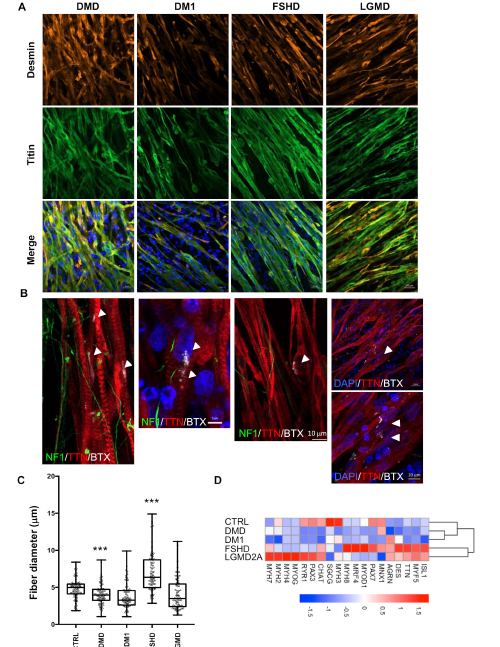
Figure 5. Structural and functional phenotyping of hiPSC-derived muscle cells from patients a ff ected by muscular dystrophy. ( A ) Representative Z stacks of myofibers at day 45 with staining of sarcomeric Desmin (DES, orange) and Titin filament (TTN, green) for Duchenne Muscular Dystrophy (DMD), myotonic dystrophy (DM1), Facio Scapulo Humeral Dystrophy (FSHD) and Limb Girdle Muscular Dystrophy Type 2A (LGMD2A). ( B ) Representative Z stacks of cultures stained for acetylcholine receptors (AChR) using Alpha Bungarotoxin coupled with Alexa 555 (White, arrows) at the surface of hiPSC-derived muscle fiber stained in red using anti-Titin (TTN, red). Antineurofilament (NF, green) was used to visualize motor neurons axons. Nuclei were counterstained with DAPI. As in the control cells, we observed the presence of several undi ff erentiated acetylcholine receptors clusters at the surface of the myofibers for the di ff erent pathologies. ( C ) We compared the muscle fiber section of the Titin-stained fibers in control cells and the four di ff erent pathologies (DMD, DM1, FSHD or LGMD2A). For each condition, 500 fibers were analyzed, and the section of the fiber was determined at three di ff erent positions along each. Box plots display the mean sizes for the di ff erent samples. Values were compared using an ANOVA multiple comparison test, followed by Brown-Forsythe and Welch correction tests; **** p < 0.0001; *** p < 0.001; ** p < 0.01. –( D ) Heatmap for expression of di ff erent muscle and motor neuron markers over time for cells di ff erentiated from the control (CTRL) or pathological (DMD, DM1, FSHD, LGMD2A) hiPSCs at D30 postdi ff erentiation, determined by RT-qPCR on biological triplicates, each realized in biological duplicates ( n = 6 per data point). The names of the di ff erent genes are indicated on the bottom. Data for additional time points (D6, D8, D12, D17 and D21) are presented in the Supplementary Information